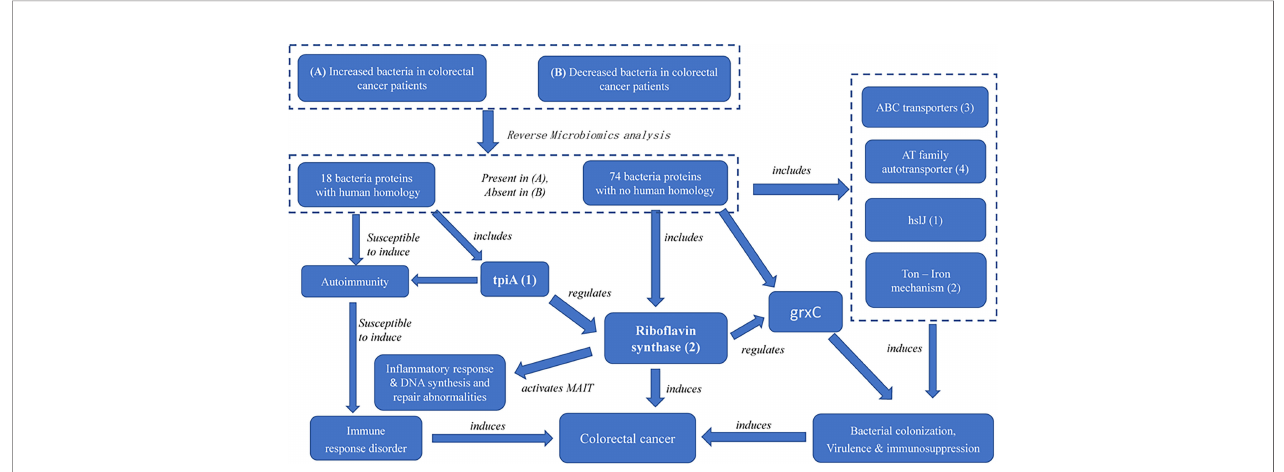
FIGURE 6 | The possible pathogenic mechanism of bacterial-derived ribo fl avin in CRC. Ribo fl avin synthase mediates a critical link among ABC transporters proteins, AT family autotransporter, HslJ, Ton, TpiA and GrxC. In the PPI network, TpiA is a upstream regulatory protein, and the GrxC is a downstream protein of ribo fl avin synthesis. All these proteins, with ribo fl avin synthesis being a central hub, likely form an interactive PPI network of the CRC